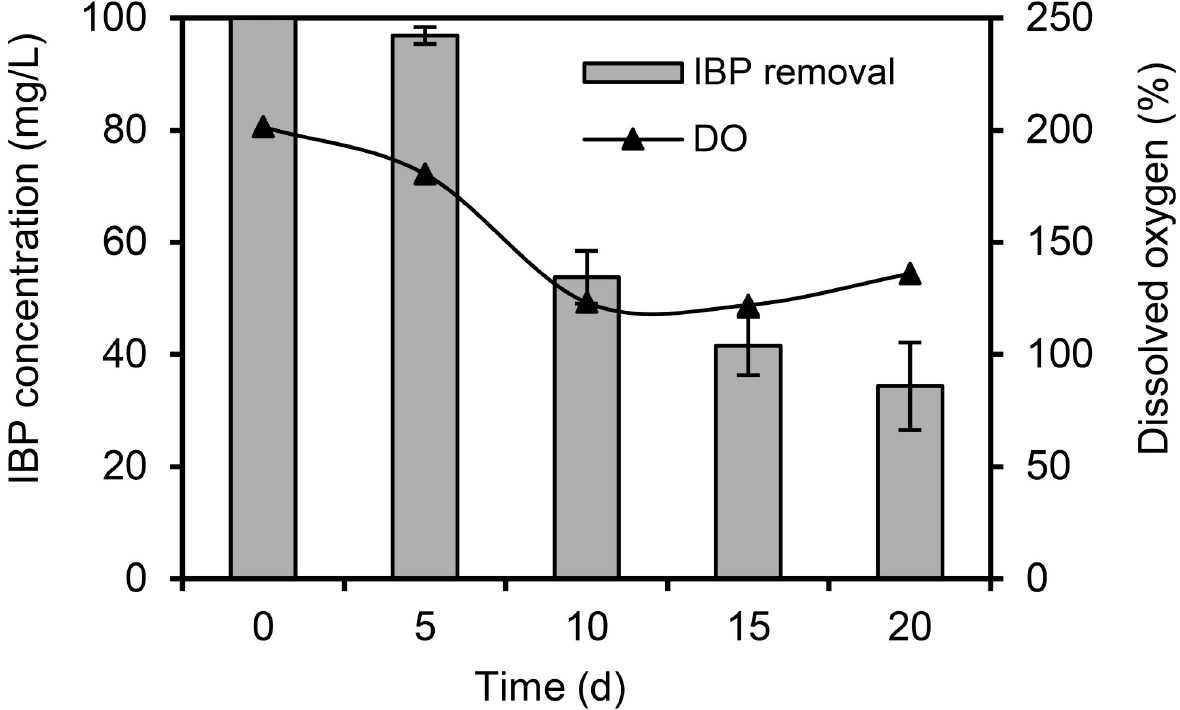
Fig 2. Biodegradation rate of IBP by R . cerastii IEGM 1278 in a laboratory bioreactor. Biodegradation experiments were conducted in the RS medium supplemented with 0.1% n -hexadecane. The graph shows mean values ± SD of three experiments.